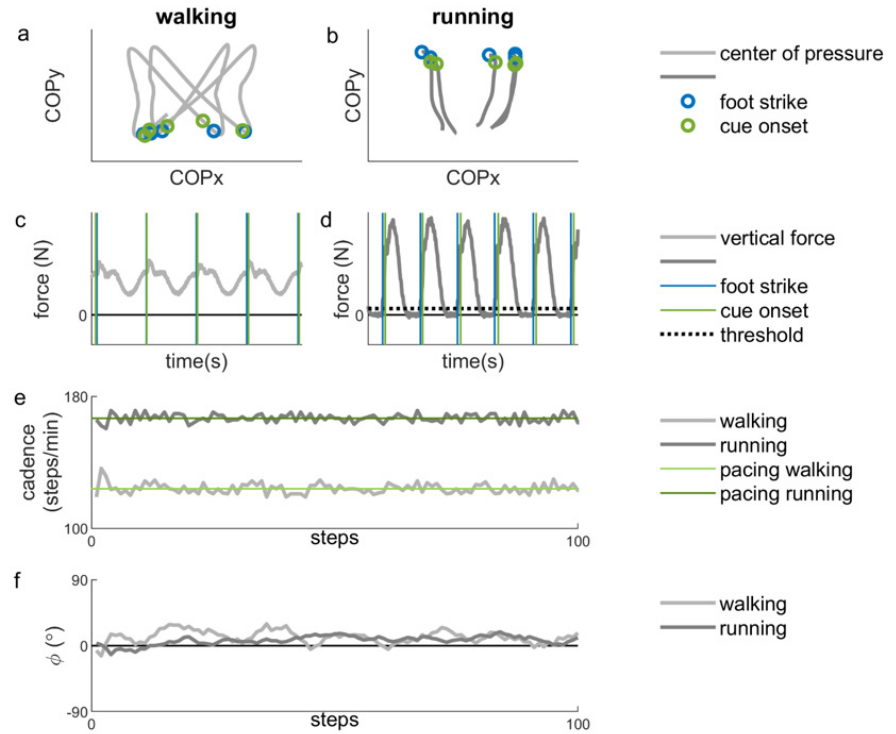
Figure 2. Example of representative data during stationary auditory-motor coordination. ( a ) The filtered (low-pass, second-order Butterworth filter with a cut-o ff frequency of 10 Hz) center of pressure (COP) for two seconds of walking for one participant. The blue circles indicate instants of foot strike and the green circles indicate cue onsets. ( b ) The filtered center of pressure (COP) for two seconds of running for one participant. The blue circles indicate instants of foot strike and the green circles indicate cue onsets (corresponding to panel d). ( c ) The vertical force data for the same two seconds of walking. The vertical blue lines indicate instants of foot strike and the vertical green lines indicate cue onsets (corresponding to panel a). ( d ) The vertical force data for the same two seconds of running. The vertical blue lines indicate instants of foot strike, defined as the moment in time when the vertical force crosses the threshold of 5% of the maximum vertical force (black dotted line). The vertical green lines indicate cue onsets. ( e ) The cadence for 100 steps of walking (light grey line) and running (dark grey line) and the corresponding (preferred) pacing frequencies (light green line for walking and dark green line for running) ( f ) The relative phase ( φ ) for 100 steps of walking (lighter grey line) and running (darker grey line). A positive relative phase indicates that the foot strikes are ahead of the